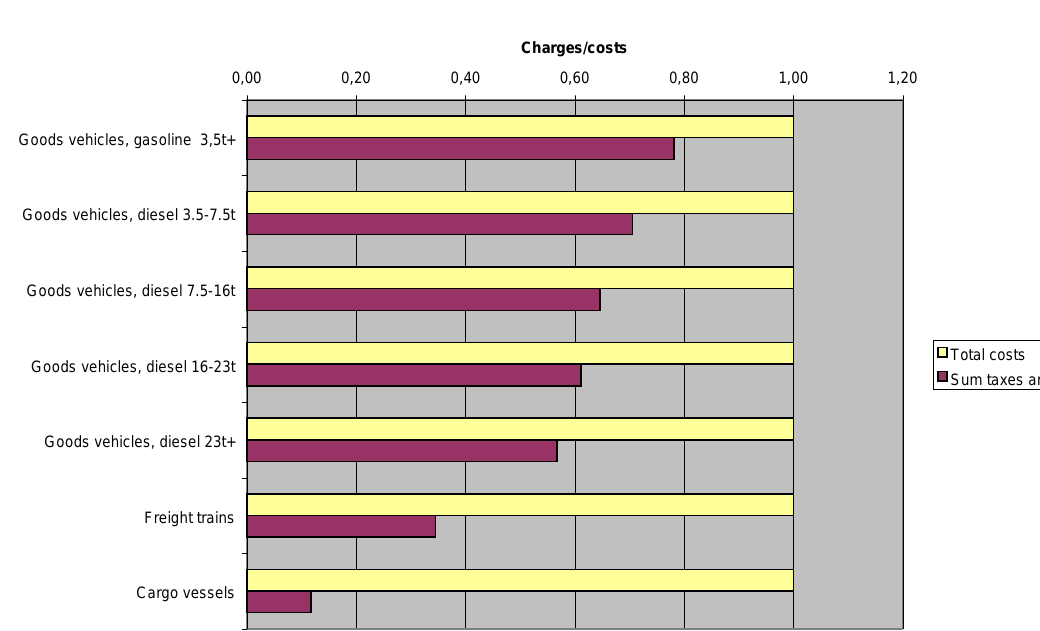
Figure 4. Marginal charges relative to external cost. Goods